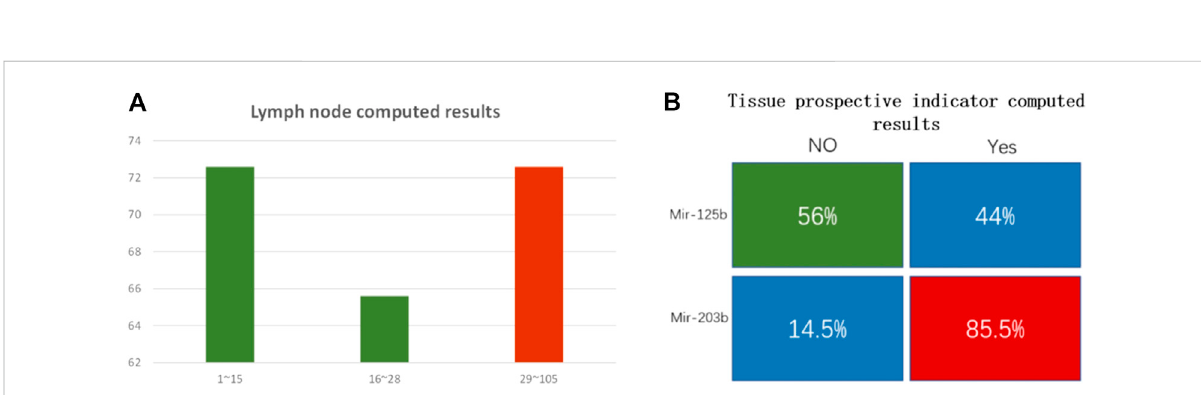
FIGURE 8 (A) Lymph nodenumbercomputedresults. The y -axisiscomputationalaccuracy. The x -axisisthenodenumber.Greenbarsshow themir-99a FAM modi fi ed group. The red bar shows the mir-451a ROX modi fi ed group. When the lymph node number is under 15, FAM dominates, and the computed accuracy is 72.6%; when the node number is between 16 and 28, FAM dominated, and the computing accuracy is 65.6%; when the node number is between 29 and 105, ROX strand dominated, the DNA computing accuracy is 72.7%. (B) Tissue prospective collective indicator computed results. The indicator “ Yes ” or “ No ” was transformed to 1 or 0. Mir-125b correlates to the 0 indicator, and the computed accuracy is 56%; mir-203b correlates to 1 indicator, and DNA computed accuracy is